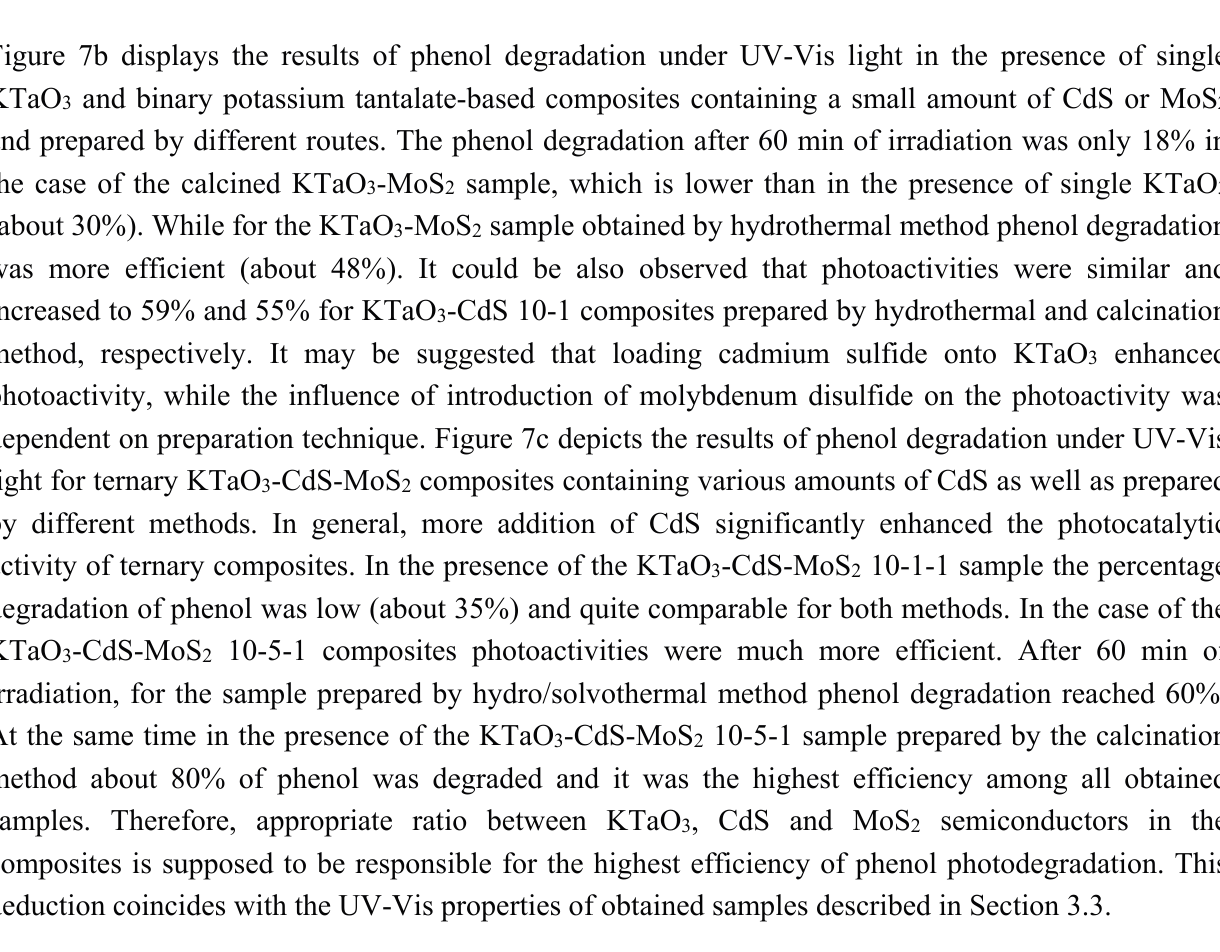
Figure 8. The percentage degradation of phenol at various time intervals under visible light in the presence of selected